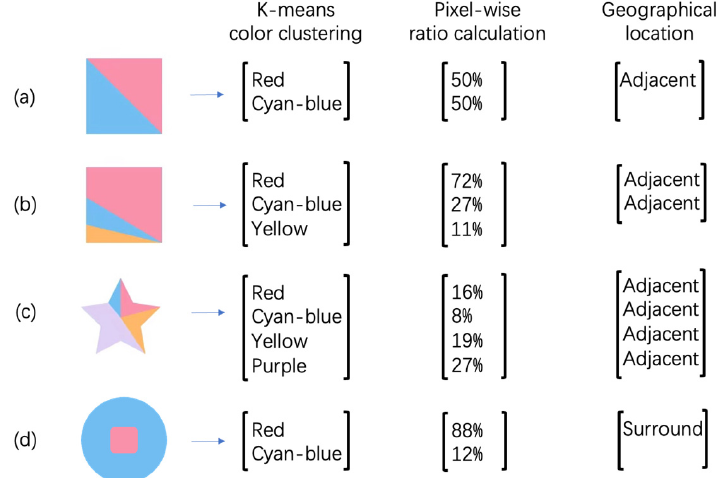
Figure 4. Color quantification of standardly shaped objects. ( a ) Square with two colors; ( b ) Square with three colors; ( c ) Star with four colors; ( d ) Round with two colors.